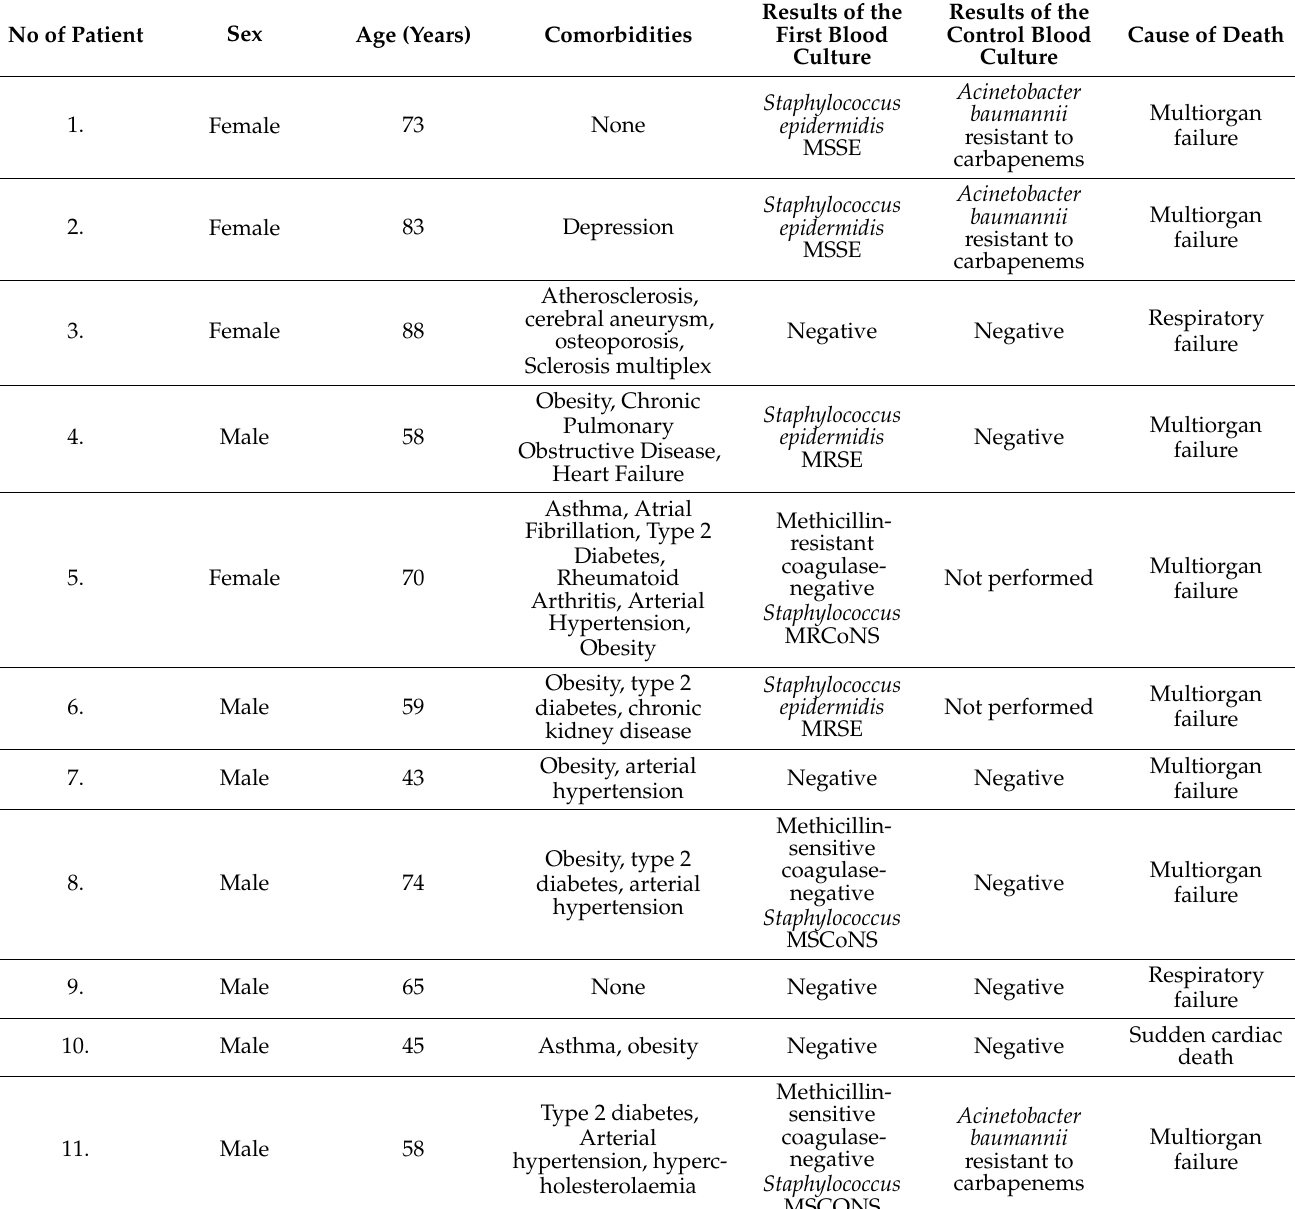
Table 2. Characteristics of SARS-CoV-2 infected individuals with the fatal